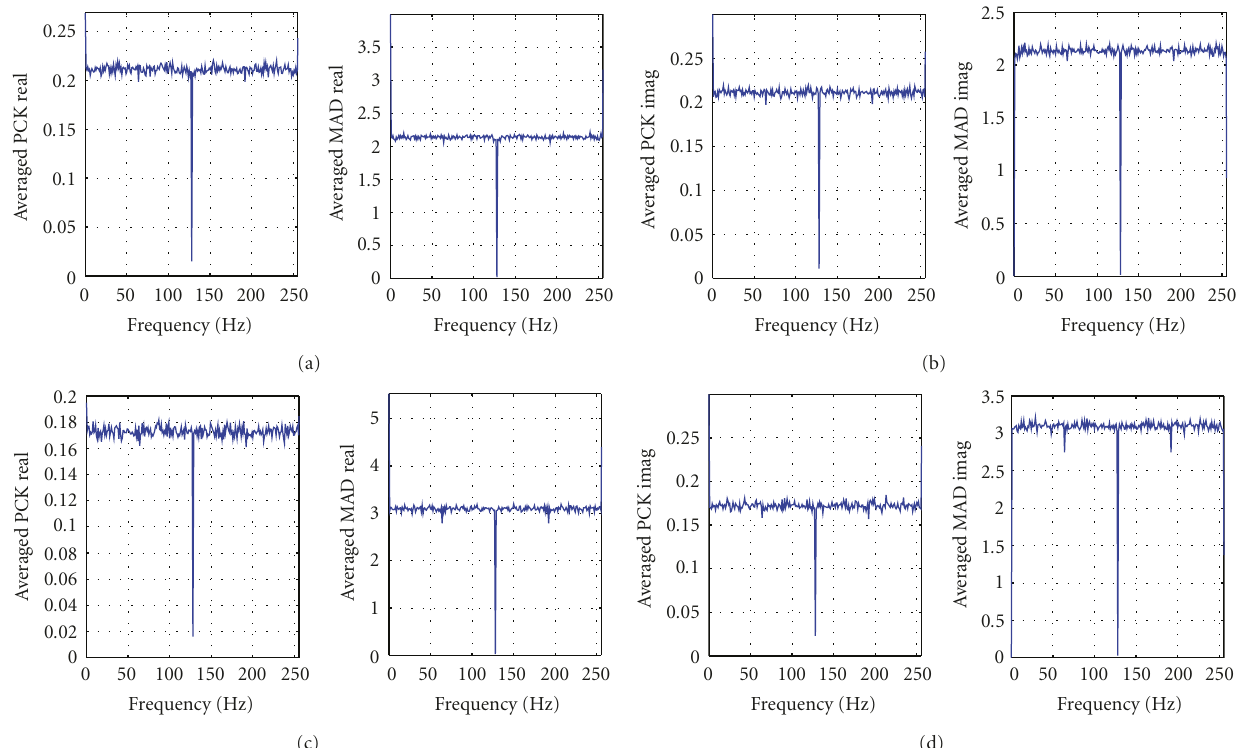
Figure 11: The plots of PCK RE ( p ), MAD RE ( p ) (left column) and PCK IM ( p ), MAD IM ( p ) (right column) for FM signal s 2 ( n ) corrupted by S α S noise with α = 1 . 5 (upper string) and α = 1 (bottom string) ( γ =